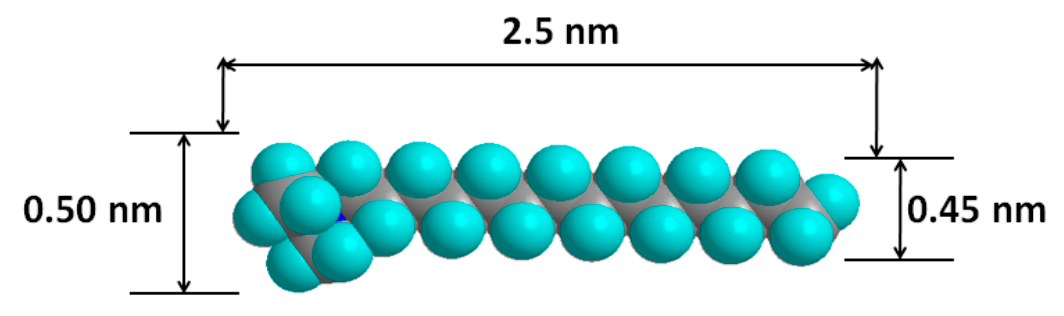
Figure 3. Model structure of the C 16 cation and its dimensions.